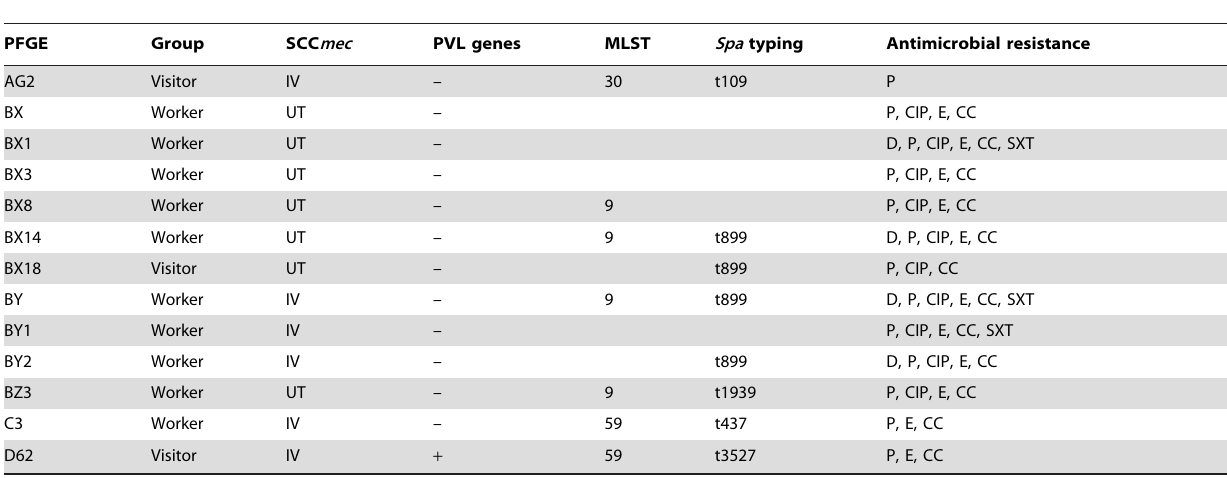
Table 5. Molecular characteristics and antimicrobial resistance of 13 MRSA isolates from humans.